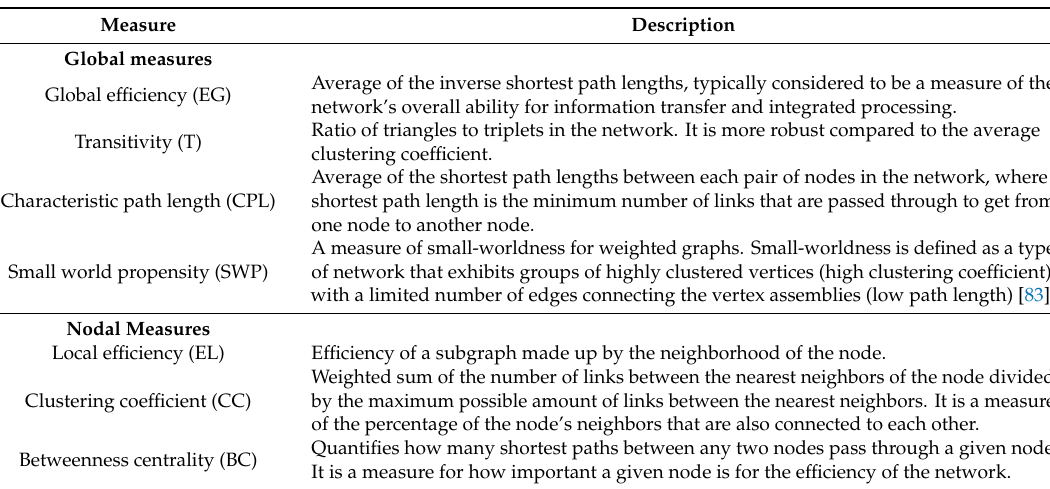
Table 3. Description of the global and local network